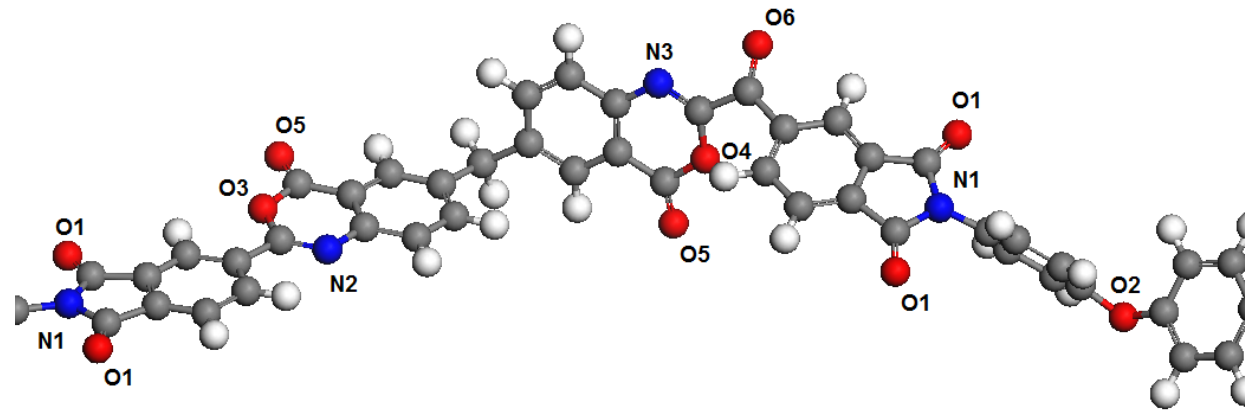
Figure 1. Fragment of the polymer chain PBOI with marked atoms according to Table 1.